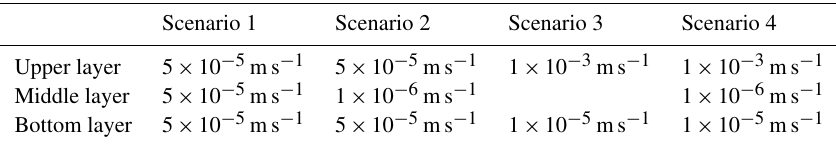
Table 2. Hydraulic conductivities of each layer for the four different